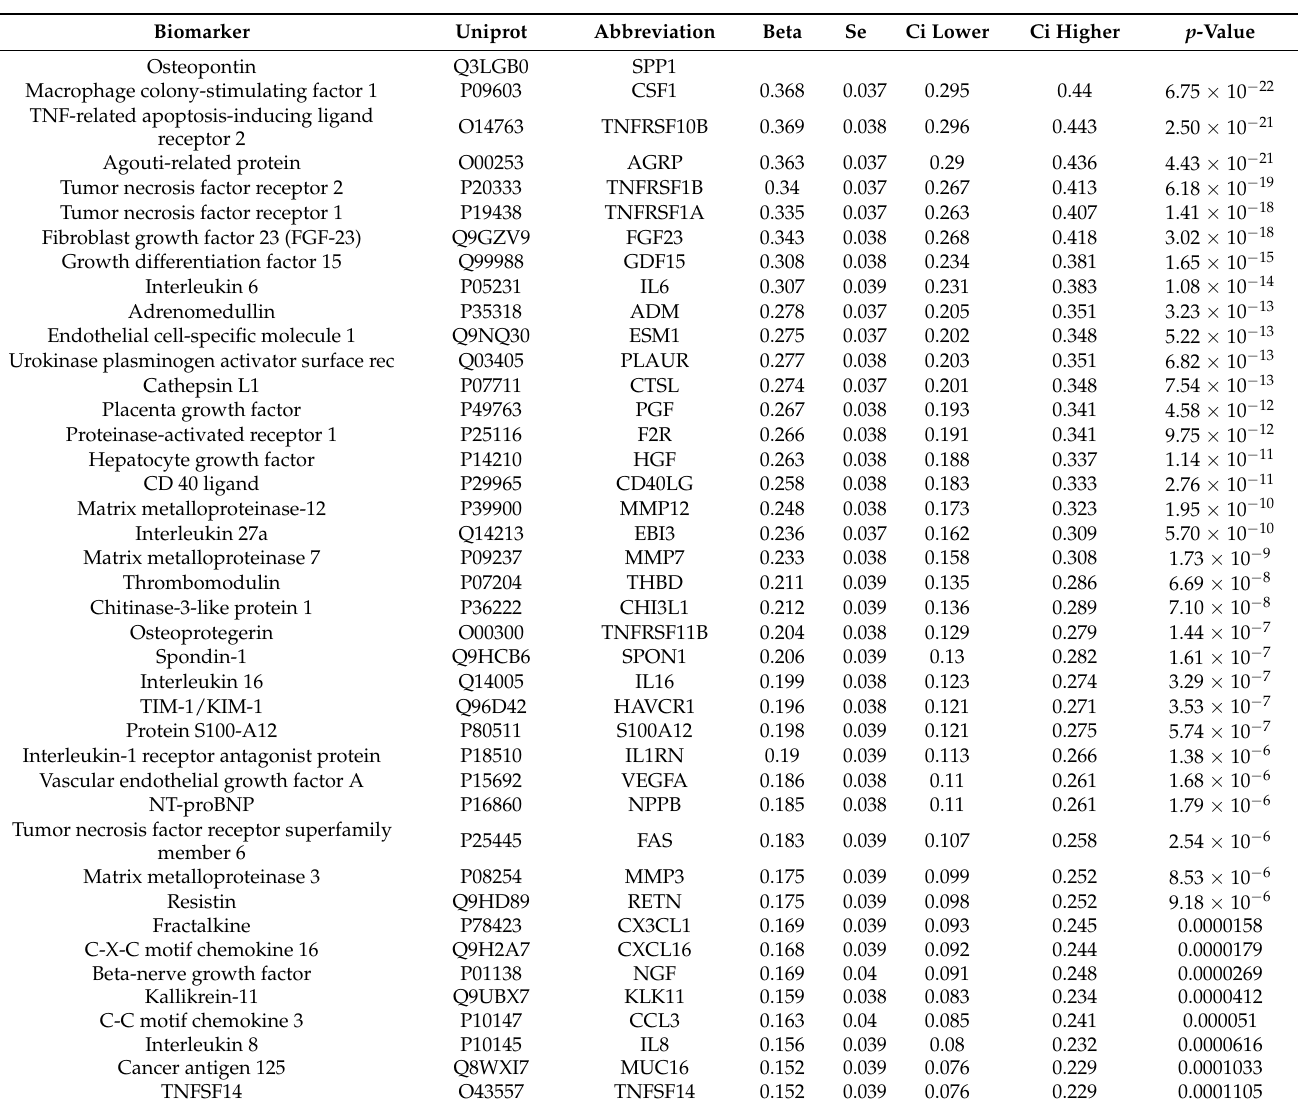
Table 2. Relationship between plasma osteopontin and the 40 cytokines that were most strongly associated with osteopontin. The correlations are adjusted for age. Significant p -values after Bonferroni adjustment ( p = 5.88 × 10 − 4 ) are highlighted in grey. All proteins were ln-transformed, and then transformed to a SD scale. n = 652. Table sorted by p -value. ci = confidence interval. The abbreviations are used in Figure